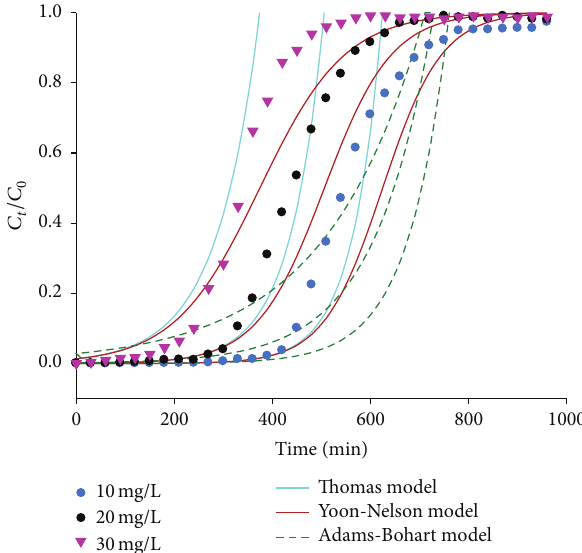
Figure 9: Effect of initial concentration on breakthrough curve (flow rates 15mL/min; bed depth 5 cm; pH 5.2).